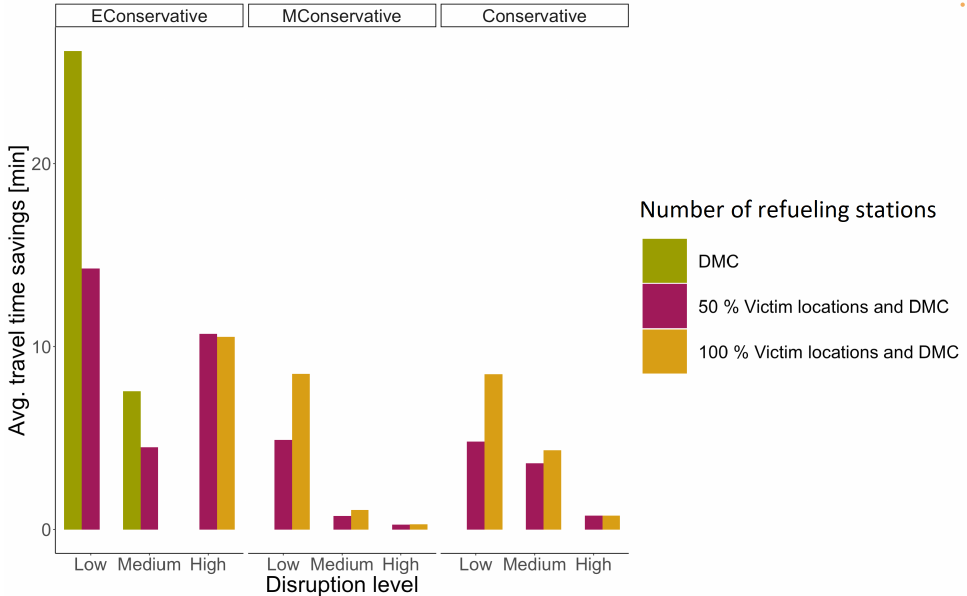
Figure 12. Cluster A: impact of the number of refueling stations on the performance of refueling